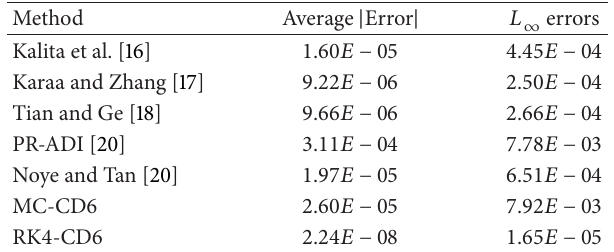
Table 3: Pulse height values of Example 2 for various values of Δ𝑡 with ℎ = 0.025 , 𝐷 𝑥 = 𝐷 𝑦 = 0.01 , and 𝑡 = 1.25